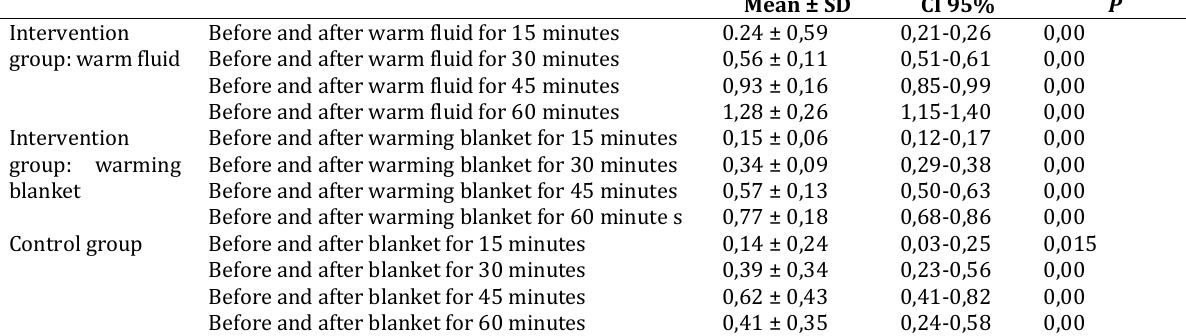
Mean ± SD CI 95% P